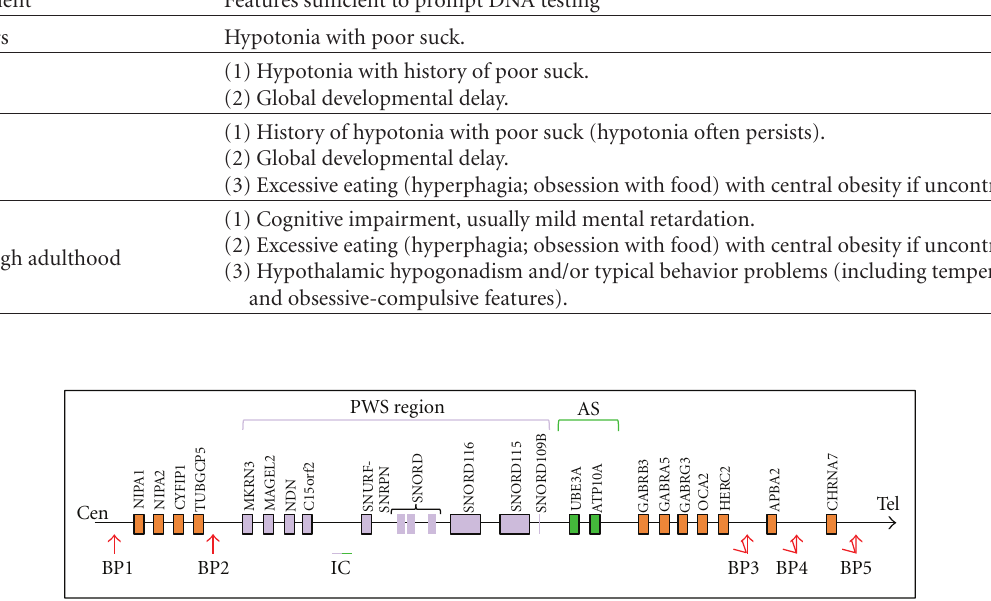
Table 1: Published revised diagnostic criteria for PWS, Gunay-Aygun et al. [5]. Age at assessment